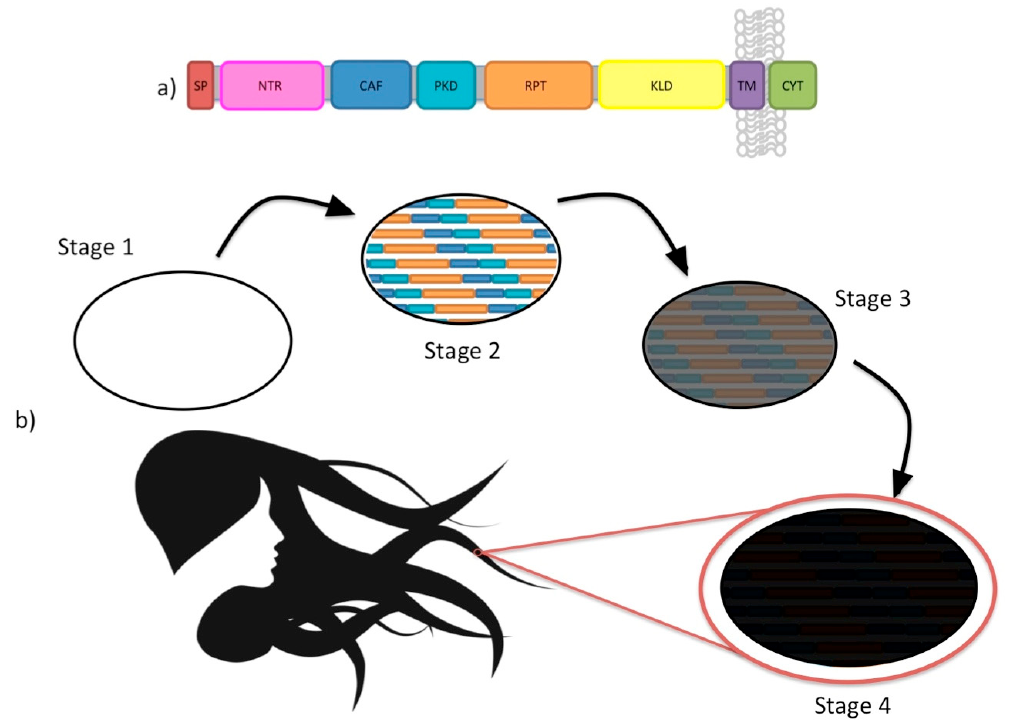
Figure 10. Premelanosome protein (PMEL) is an intriguing example of a vertebrate functional amyloid that, when processed, forms fibrils within melanosomes. PMEL in melanosomes sequesters the pigment melanin and is responsible for the pigment present in our eyes, hair, and skin. ( a ) A general schematic of the domains and regions of the PMEL protein: Signal Peptide (SP), N-terminal Region (NTR), Core Amyloid Fragment (CAF), Polycystic Kidney Domain (PKD), Repeat Region (RPT), Kringle-like Domain (KLD), Transmembrane Domain (TM), Cytoplasmic Domain (CYT); ( b ) The process of melanosome maturation and the integral function of PMEL in the sequestering of melanin pigment, which can be found in the skin, hair, and eyes. Stage 1: Also called the early endosome stage, this is the initial stage of a melanosome before PMEL fibrils are formed within the organelle. Stage 2: In the stage 2 melanosome, processed fragments of PMEL, i.e., CAF, PKD, and RPT, fibrilizes in the melanosome. Stage 3 and Stage 4: Melanin deposits onto the fibrils of PMEL giving the organelle its dark pigment.